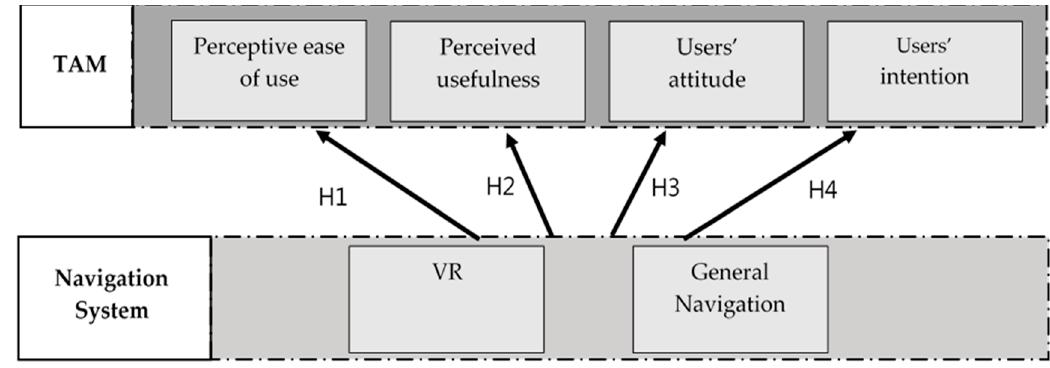
Figure 3. Research hypotheses.